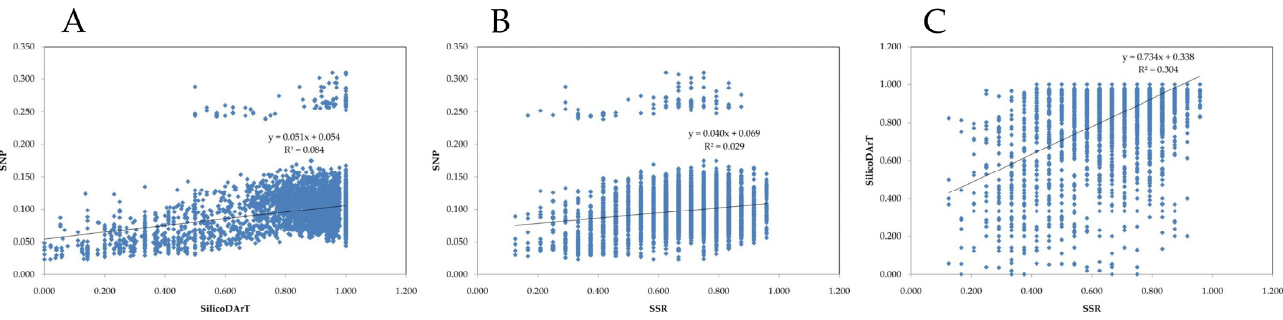
Figure 11. Mantel correlation test between SilicoDArT and SNP markers ( A ), SSR and SNP markers ( B ) and SSR and SilicoDArT markers ( C ).